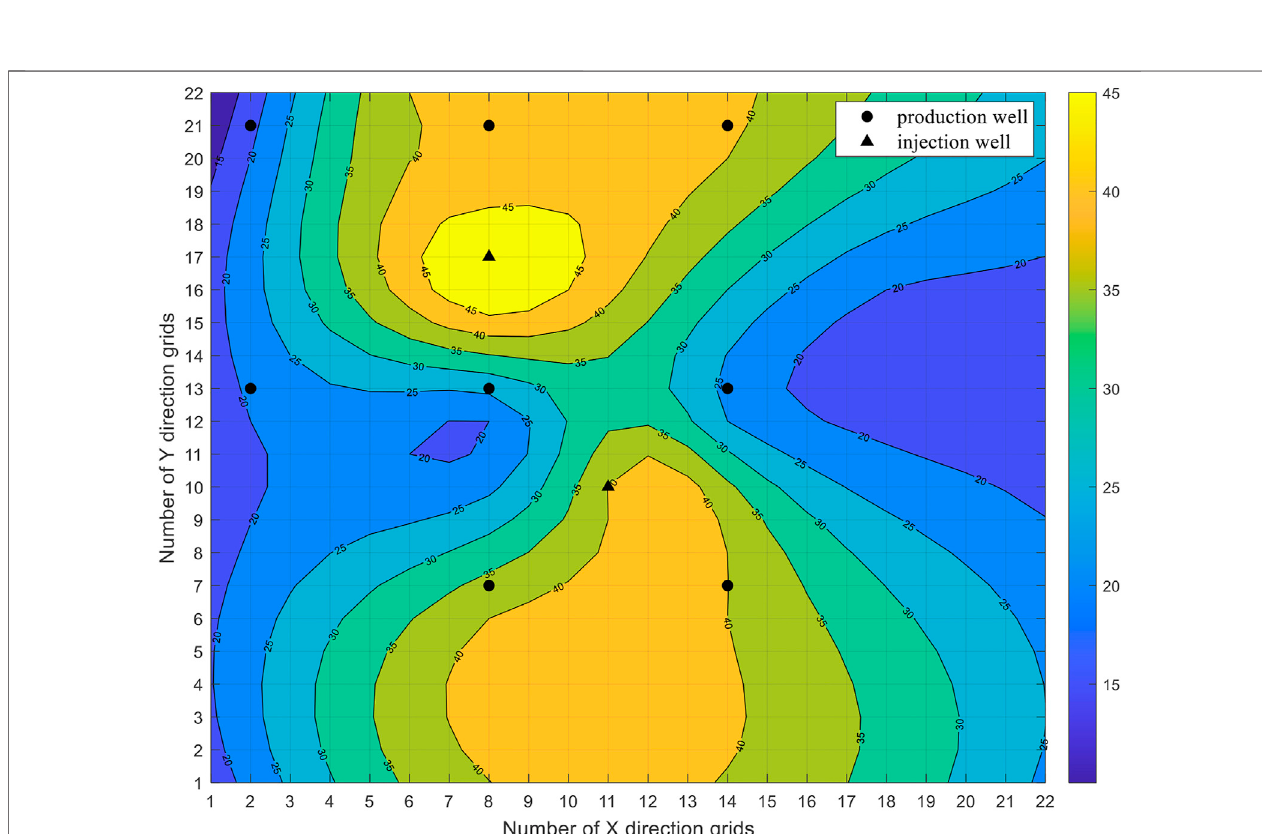
FIGURE 5 | Permeability distributing graph of reservoir numerical simulation.